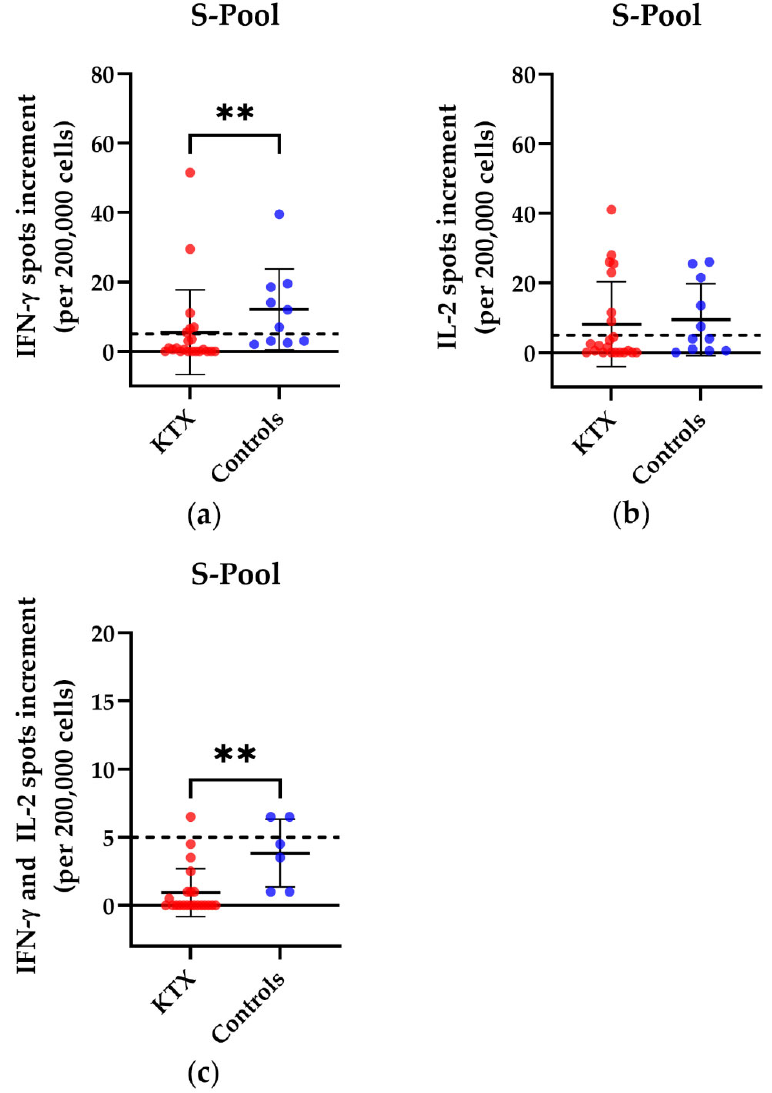
Figure 1. SARS-CoV-2-specific CoV-iSpot responses in kidney transplant (KTX) patients and healthy volunteers after booster vaccination. Distribution of ( a ) IFN- γ , ( b ) IL-2, and ( c ) simultaneous IFN- γ and IL-2 CoV-iSpot responses after stimulation with the S pool of the wild type SARS-CoV-2. Please note the different scales. Red circles show data of the KTX patients, while blue circles indicate data of the healthy volunteers. Two ‐ tailed Mann–Whitney tests were used to compare the responses (** p < 0.01). Mean values are represented by horizontal lines, while the standard deviation is represented by error bars. The horizontal line shows the zero line. The dashed line indicates the cut ‐ off.